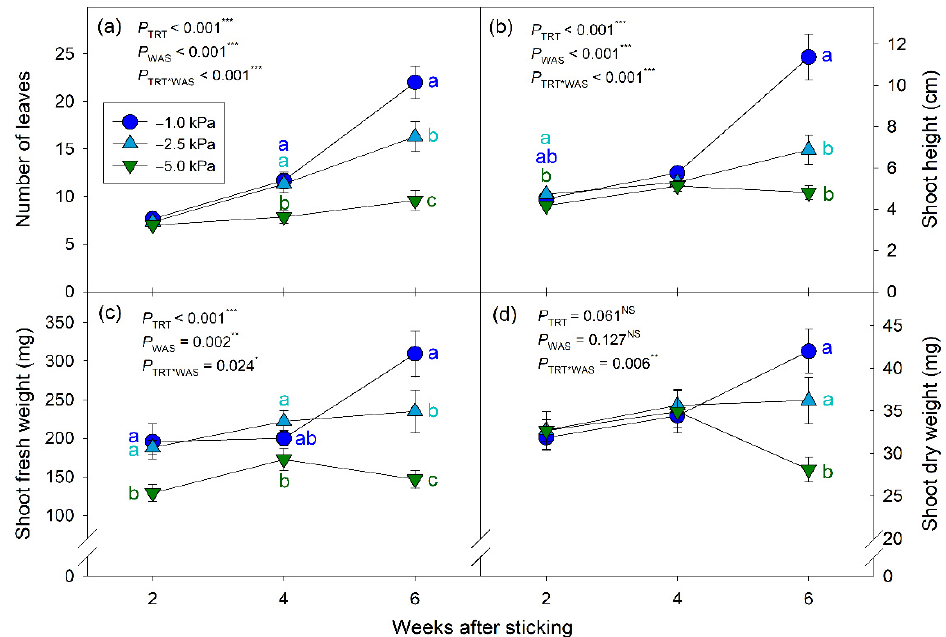
Figure 5. Shoot properties of English lavender ( Lavandula angustifolia ) cuttings at three irrigation thresholds ( − 1.0, − 2.5, and − 5.0 kPa) over six weeks. ( a ) The number of leaves, ( b ) shoot height, ( c ) shoot fresh weight, and ( d ) shoot dry weight. Points marked with the same letter are not signifi- cantly different according to Duncan’s multiple range test at α ≤ 0.05 (significance at each week of observation). * , ** , *** , or NS indicates significance at p ≤ 0.05, 0.01, 0.001, or not significant, respectively. Error bars indicate standard errors.